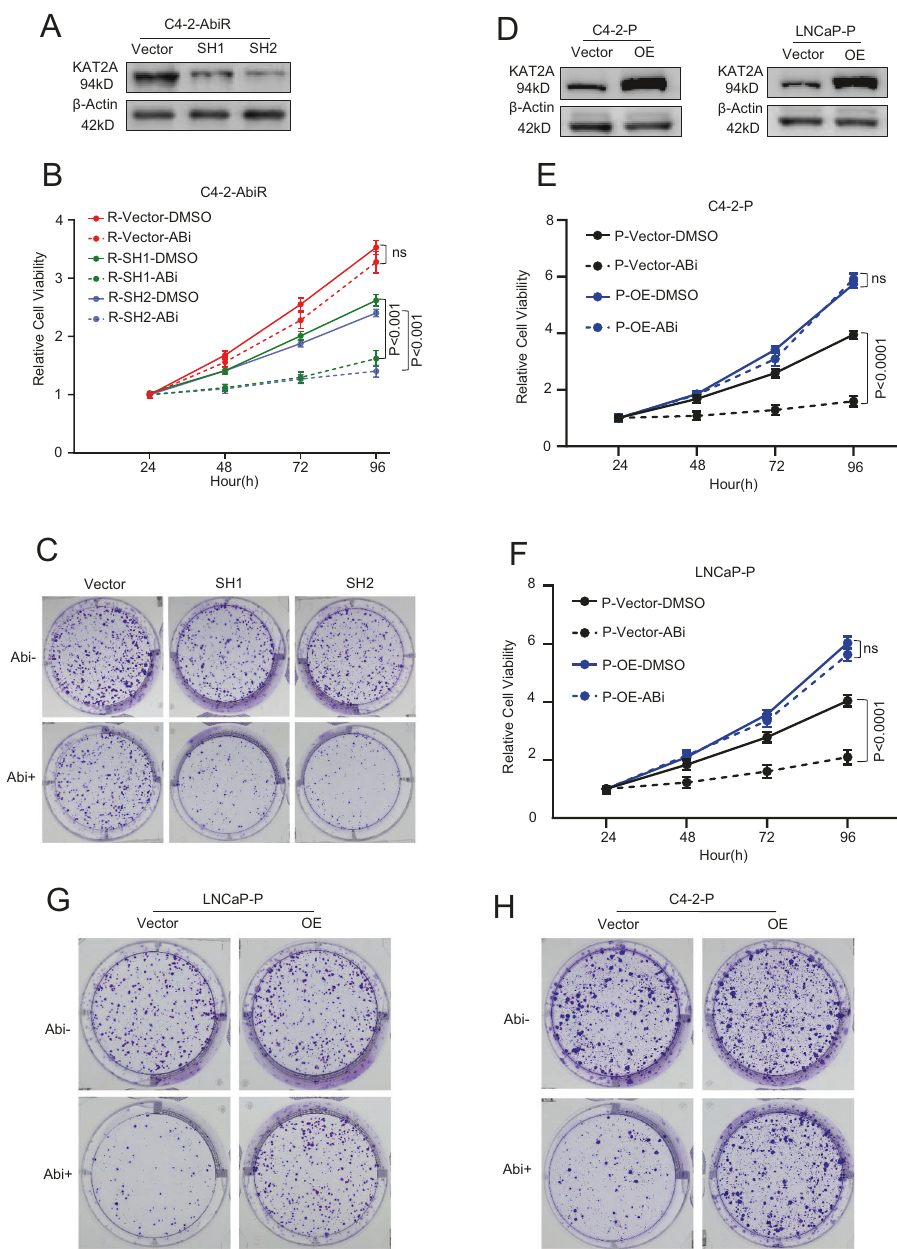
Fig. 3 The regulation of KAT2A can modify resistance to abiraterone in PC. A Identi fi cation of KAT2A silence in C4-2-AbiR. B Relative cell viabilities of C4-2-AbiR stably transfected with sh-KAT2A plasmids or vectors were detected by CCK-8. C Proliferation ability of C4-2-AbiR stably transfected with sh-KAT2A plasmids or vectors were detected by colony formation assay. D Identi fi cation of KAT2A overexpression in C4-2-P and LNCaP-P. E, F Relative cell viabilities of C4-2-P and LNCaP-P stably transfected with OE-KAT2A plasmids or vectors were detected by CCK-8. G, H Proliferation ability of C4-2-P and LNCaP-P stably transfected with OE-KAT2A plasmids or vectors were detected by colony formation